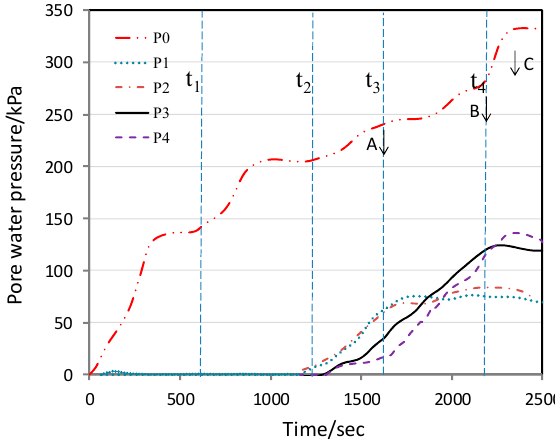
Figure 14. Variations of surface settlement with time in model slope.